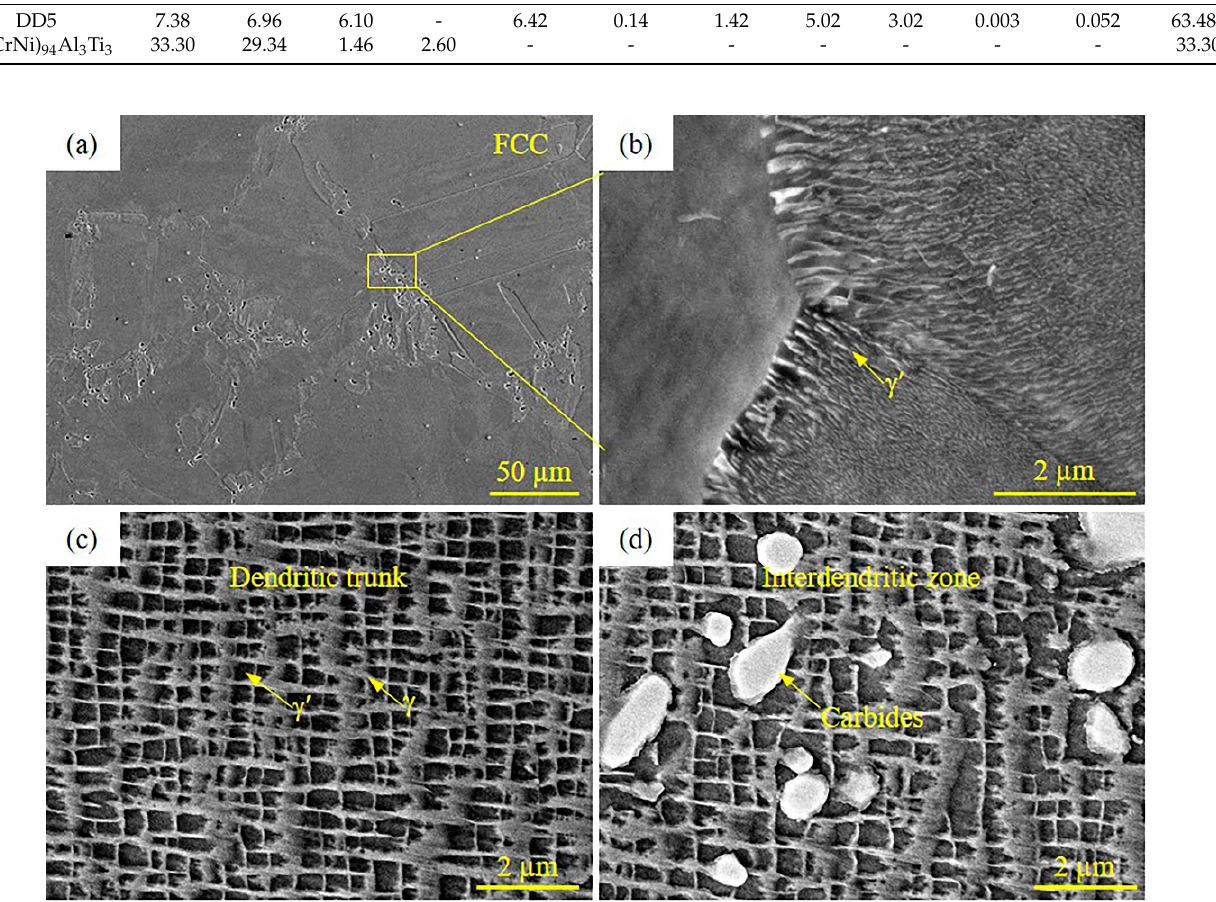
Figure 1. Microstructure of the base materials: ( a ) (CoCrNi) 94 Al 3 Ti 3 MEA and ( b ) corresponding magnified morphology; ( c ) dendritic trunk and ( d ) interdendritic zone of DD5 single-crystal superalloy.